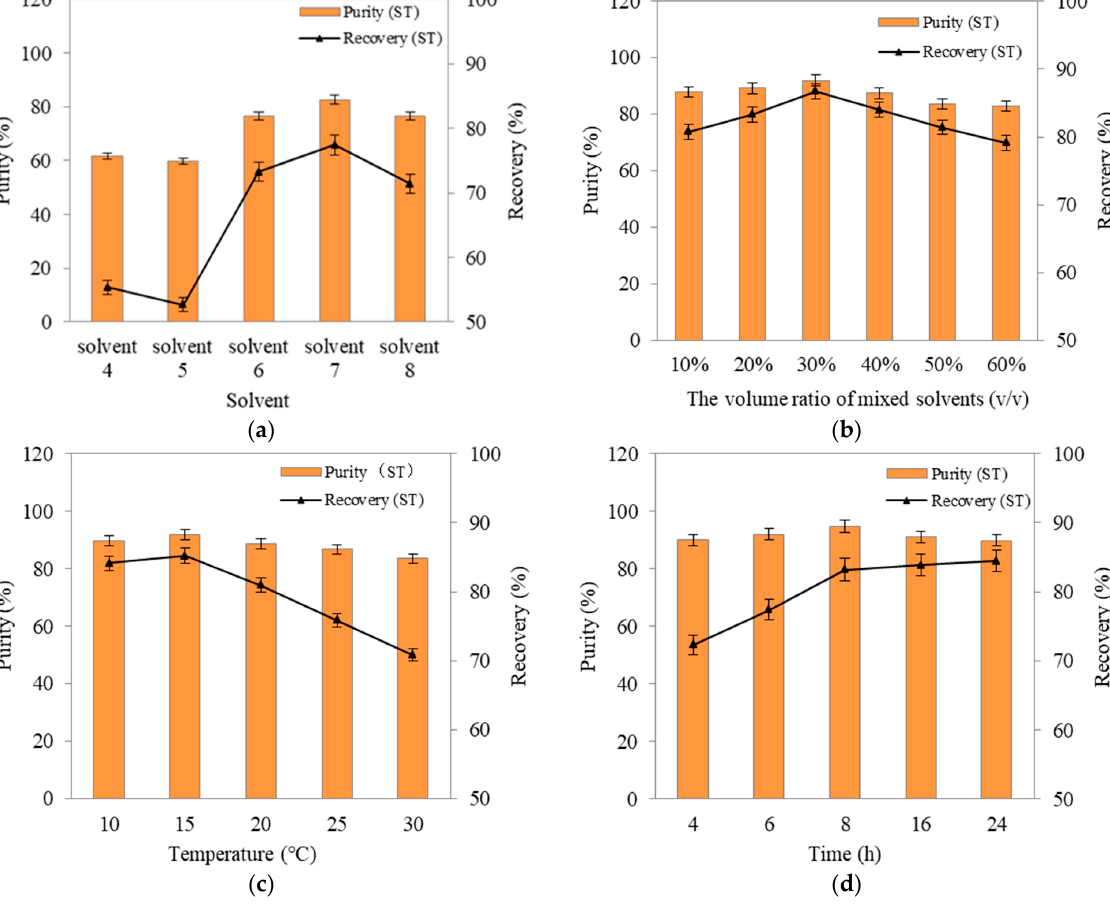
Figure 6. Effect of ( a ) solvent composition (1:6 of the solid-liquid ratio, 16 h, and 25 °C), ( b ) volume ratio of mixed solvents (1:6 of the solid-liquid ratio, 16 h, and 25 °C), ( c ) recrystallization time (1:6 of the solid-liquid ratio, the volume ratio of mixed solvent (solvent 3/solvent 1 = 30%), and 25 °C), and ( d ) temperature (1:6 of the solid-liquid ratio, the volume ratio of mixed solvent (solvent 3/solvent 1 = 30%), and 16 h on purity and recovery of ST from MLS.